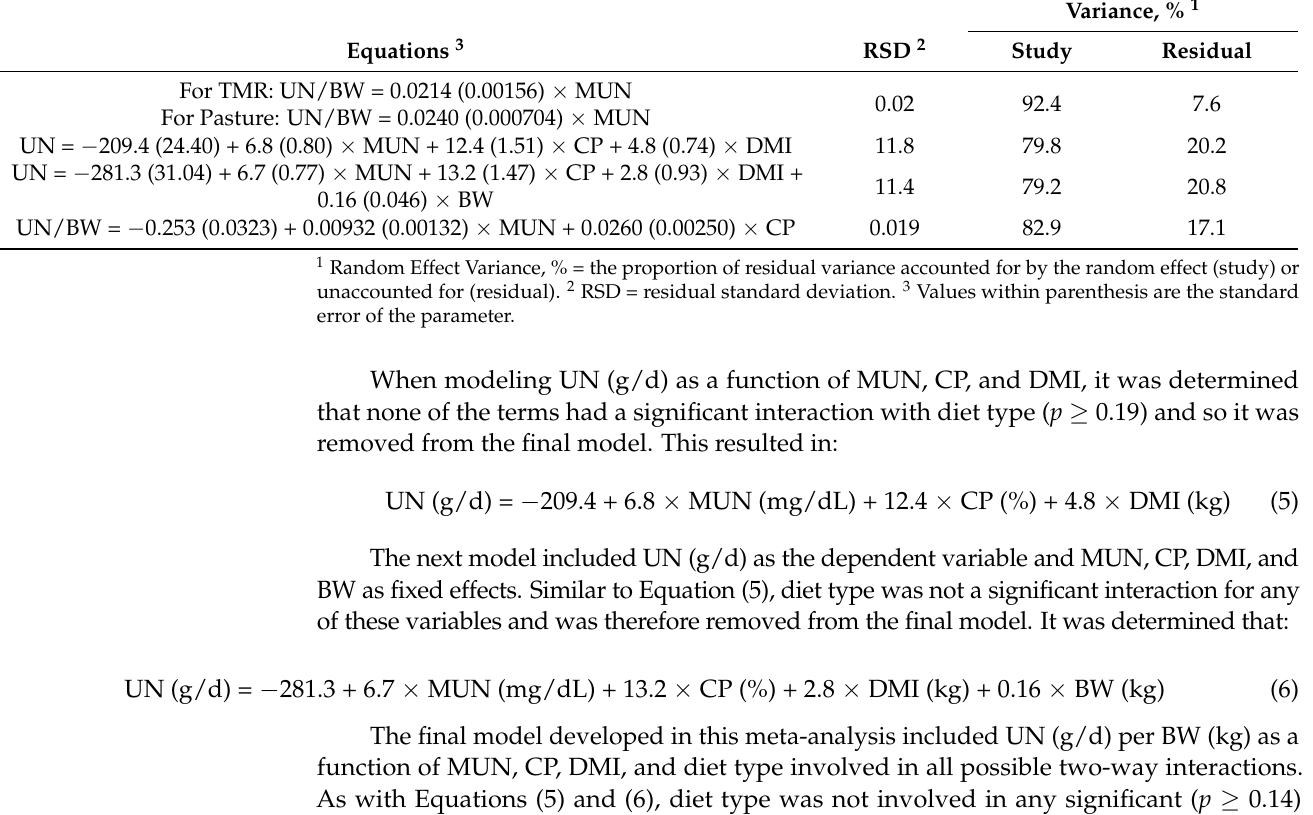
Equations 3 RSD 2 Study